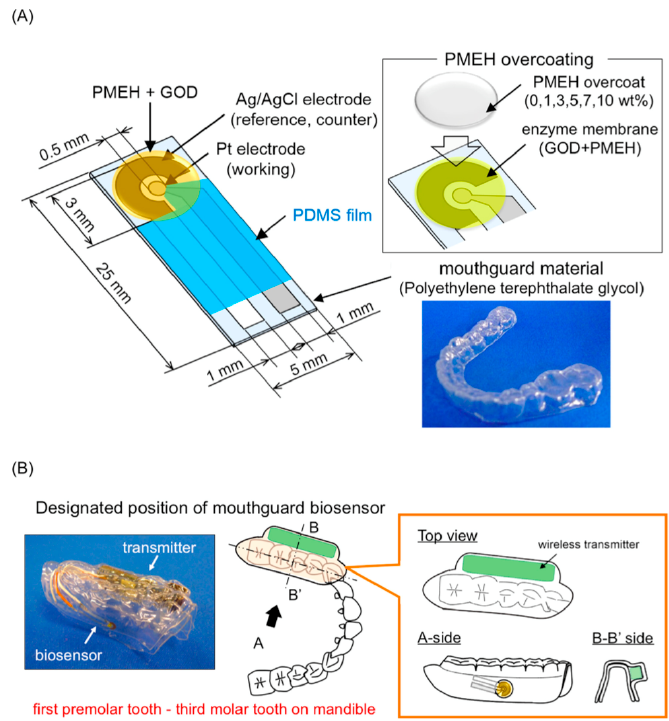
Figure 7. ( A ) Schematic image of the glucose biosensor on the polyethylene terephthalate glycol mouthguard support. Pt and Ag electrodes were formed on the PETG through a sputtering process. Each electrode sensor consisted of a 0.20 mm 2 Pt working electrode and a 4.0 mm 2 Ag/AgCl reference/counter electrode, both insulated with PDMS on a 0.5 mm thick PETG layer. 30 units of GOD were applied to the sensing region of the working electrode. In order to optimize enzyme entrapment, 2.0 mL of 1.0 wt% PMEH solution was spread over the sensing region to form the PMEH overcoat; ( B ) Schematic image of the mouth-guard biosensor custom-fit to the patient’s dentition. The device consists of a glucose sensor and wireless transmitter incorporating a potentiostat for stable glucose measurement. The sensor was designed to fit the mandibular dentition from the first premolar up to the third molar. The wireless transmitter was neatly encased in PETG. Reprinted with permission from [94].